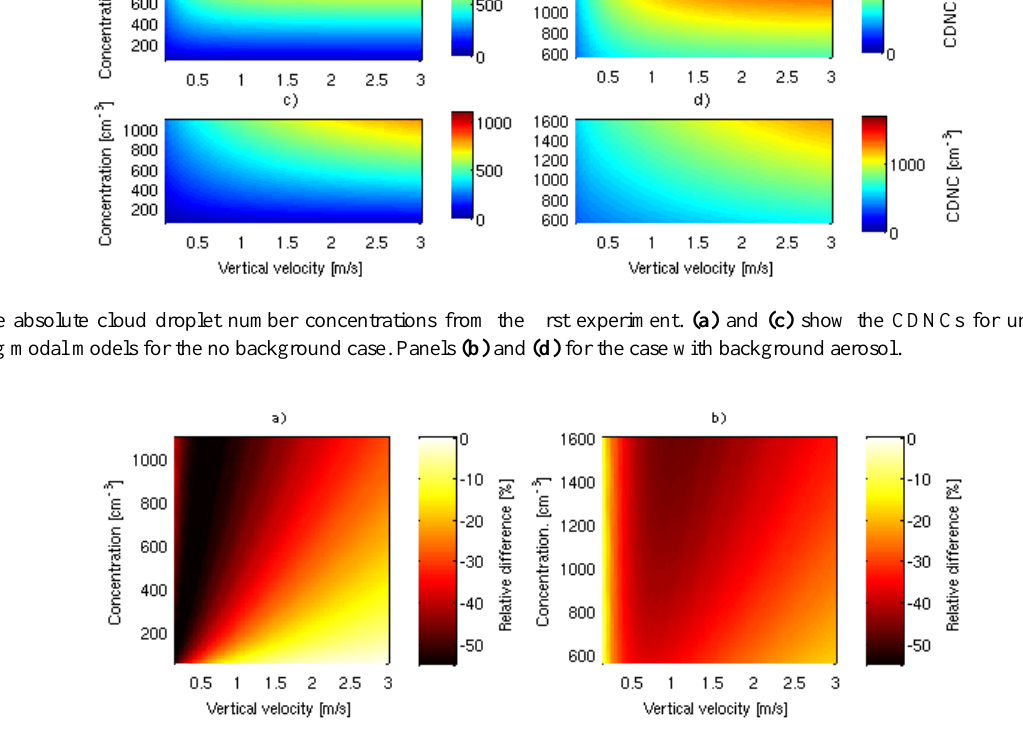
Figure 3: Relative difference of the CDNC between the reallocating and unrestricted modal models in experiment 1. a) shows the difference without and b) with background aerosol.